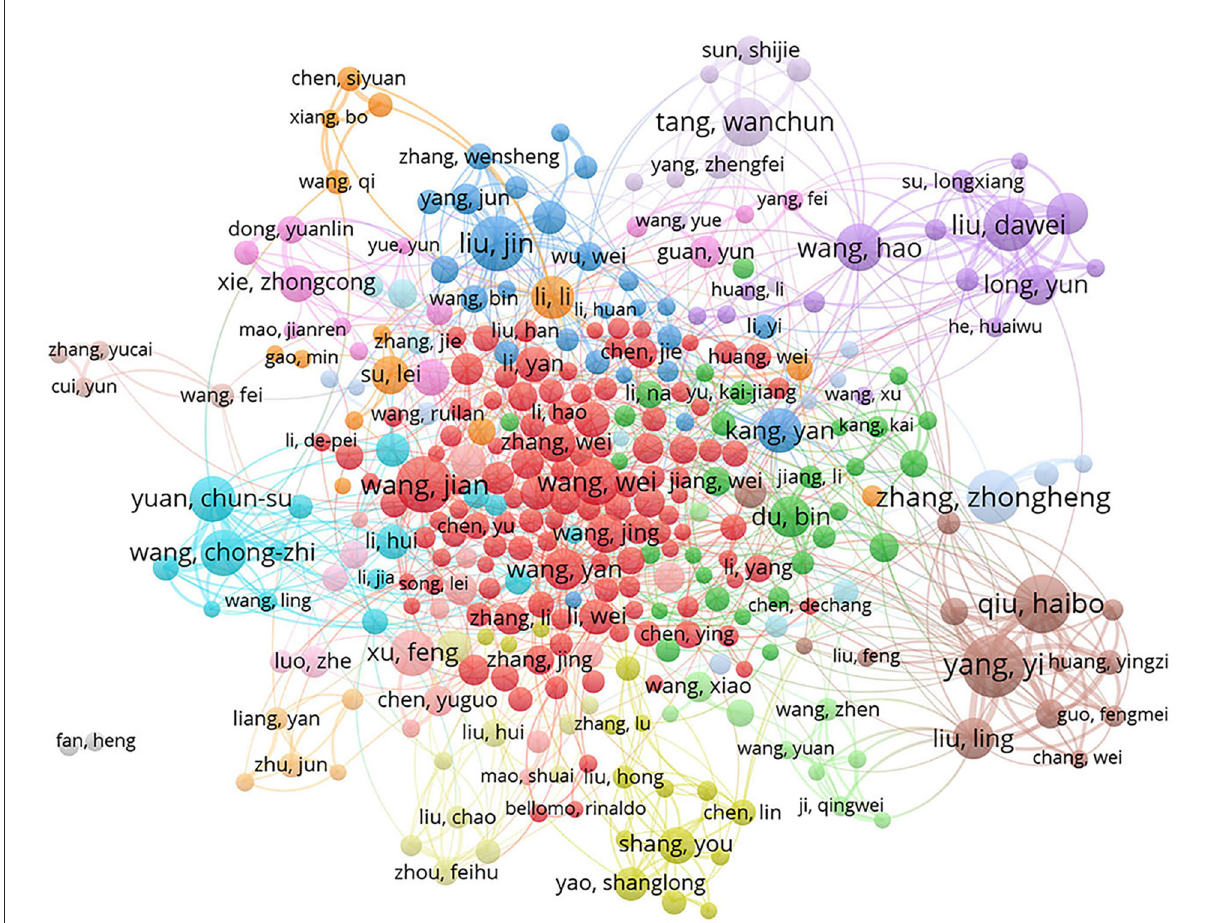
FIGURE4 Cluster visualization map of the authors Co-authorship in research of Critical Care Medicine from 2001 to 2020. Each circle represented one author and circle size indicated number of his/her publications from 2001 to 2020. The lines between two circles indicated co-appearance of authors in an article. The thickness of lines indicated strength of linkage calculated by the number of publications. The color of each circle indicated cluster, which was a set of authors calculated in the co-authorship network as a